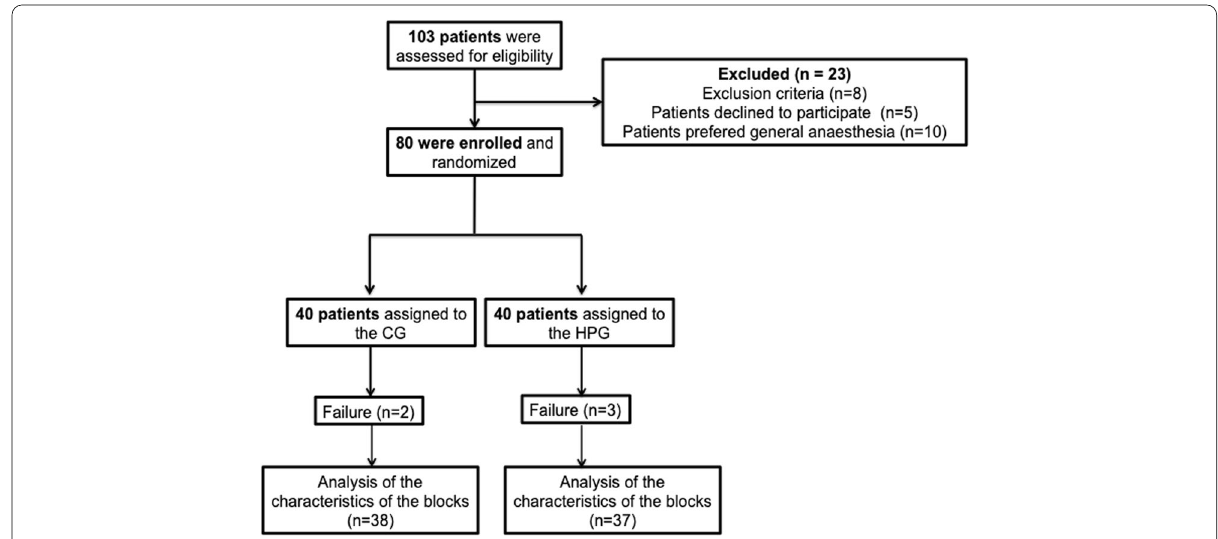
Fig. 1 Flowchart patients scheduled for knee arthroscopy with Chloroprocaine (CG) or Hyperbaric prilocaine